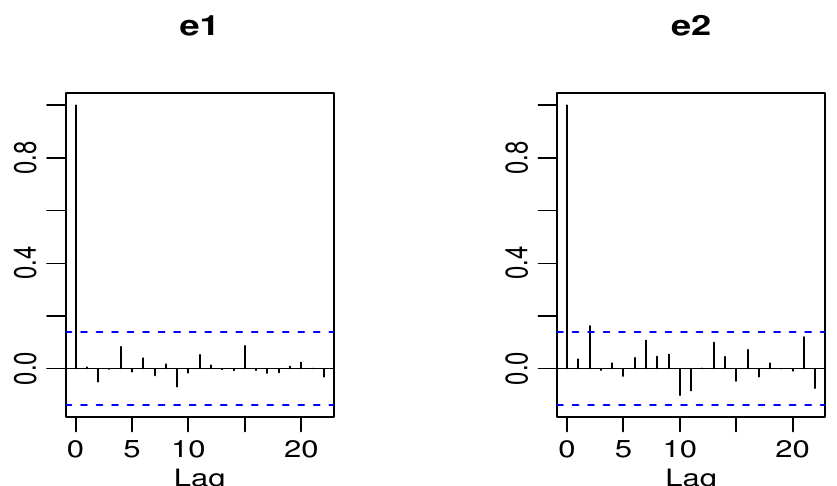
Figure 11. ACF of standardized residuals of Candies1 and Candies2 data for the BINAR(1)BP2S-L(II)